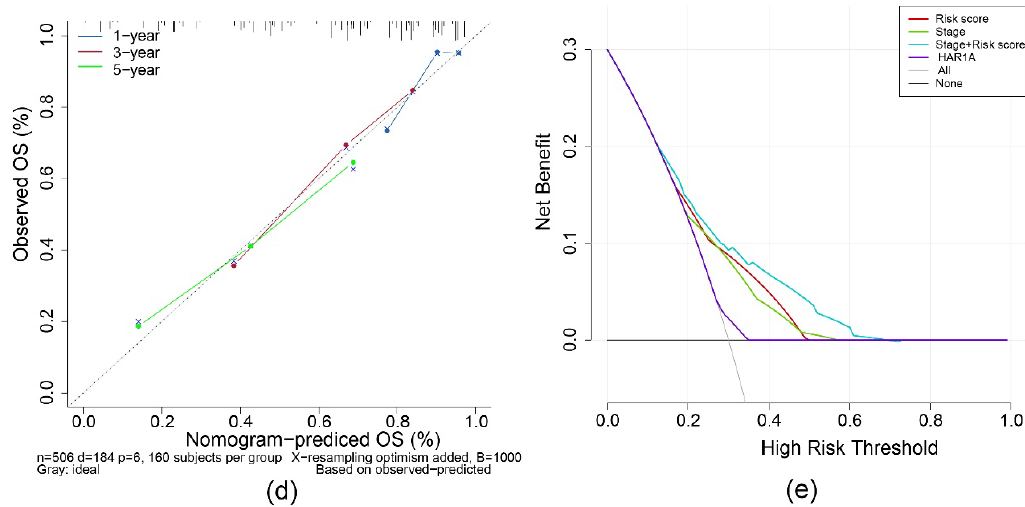
Figure 3. Evaluation of the prognostic value of risk score. ( a ) Univariate analysis to dissect the factors significantly associated with OS. ( b ) Multivariate analysis to determine the independent prognostic factors. ( c ) Nomogram for the prediction of 3- and 5-year survival. ( d ) Calibration curves illustrate the concordance between predicted and actual survival possibilities within 3 and 5 years. ( e ) Decision curve analysis unveils that the combination of risk score and TNM stage is superior to TNM stage alone across threshold probabilities of survival between 18% and 80%. The grey and blue lines depict a ‘treat none’ strategy and ‘treat all’ strategy, respectively.